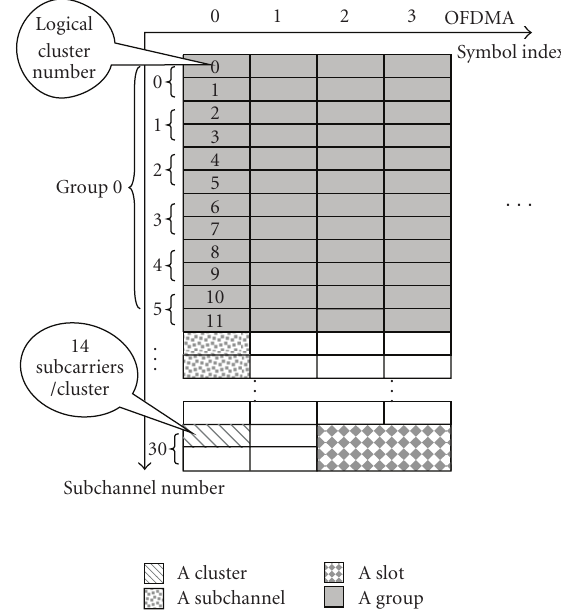
Figure 3: Basic elements in DL-PUSC